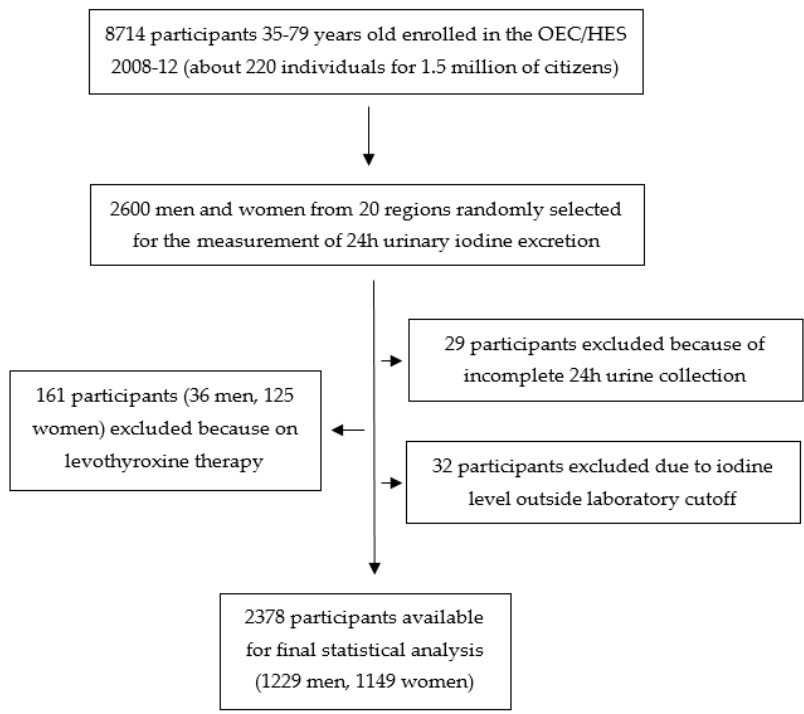
Figure 1. Flowchart of the study population.